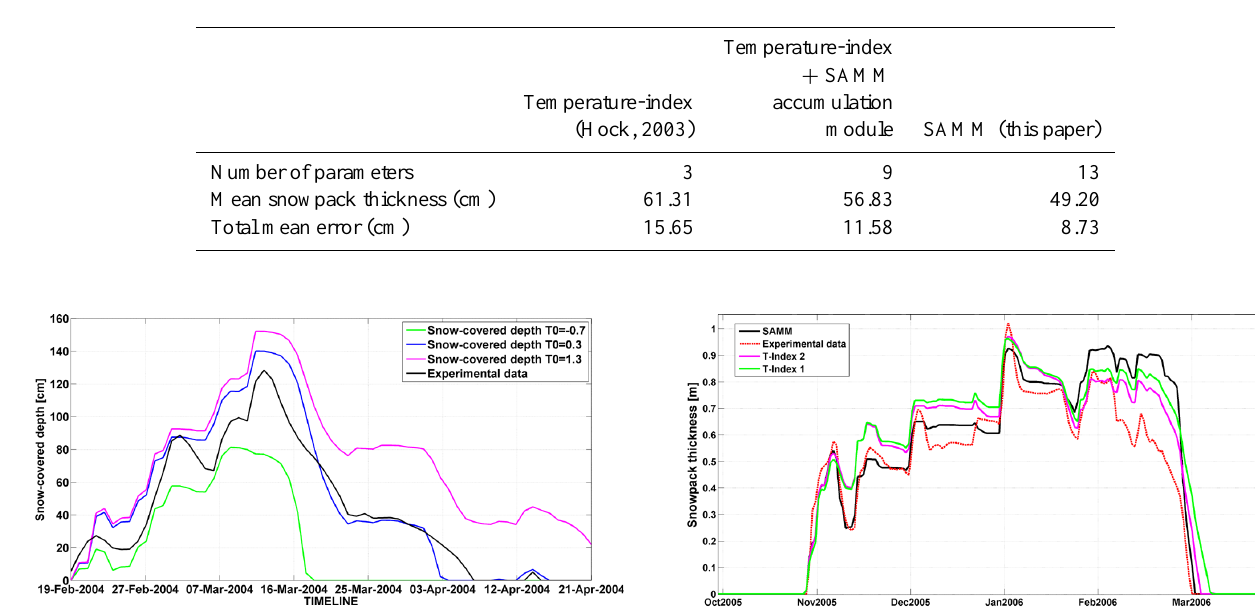
Table 4. Comparison of mean snowpack thickness and total mean error obtained for the different models with the validation dataset.